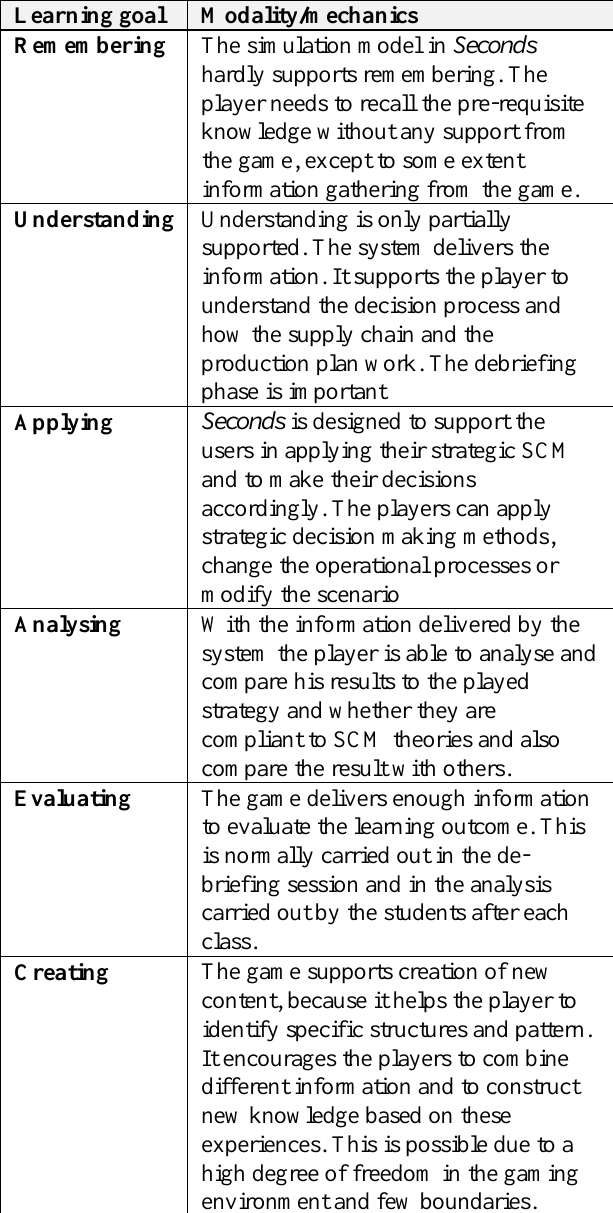
Table 6: Bloom’s cognitive learning goals